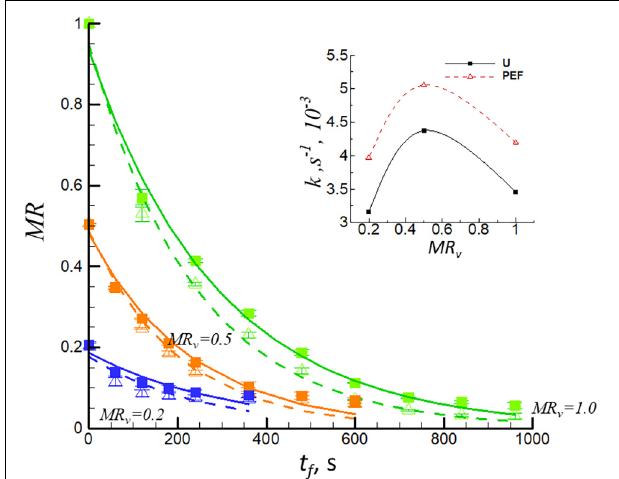
FIGURE 2 | Moisture ratio, MR , vs. the frying time, t f , for U (solid lines, filled symbols) and PEF pre-treated (dashed lines, open symbols) samples. The samples were preliminary dehydrated by VD to different levels ( MR v = 0.5 and MR v = 0.2) and then they were fried at 150 ◦ C. The curves for undehydrated samples ( MR v = 1.0) are also presented. Insert of Figure 1 shows the frying rate constant ( k ) for untreated (U) and PEF pre-treated samples (PEF).